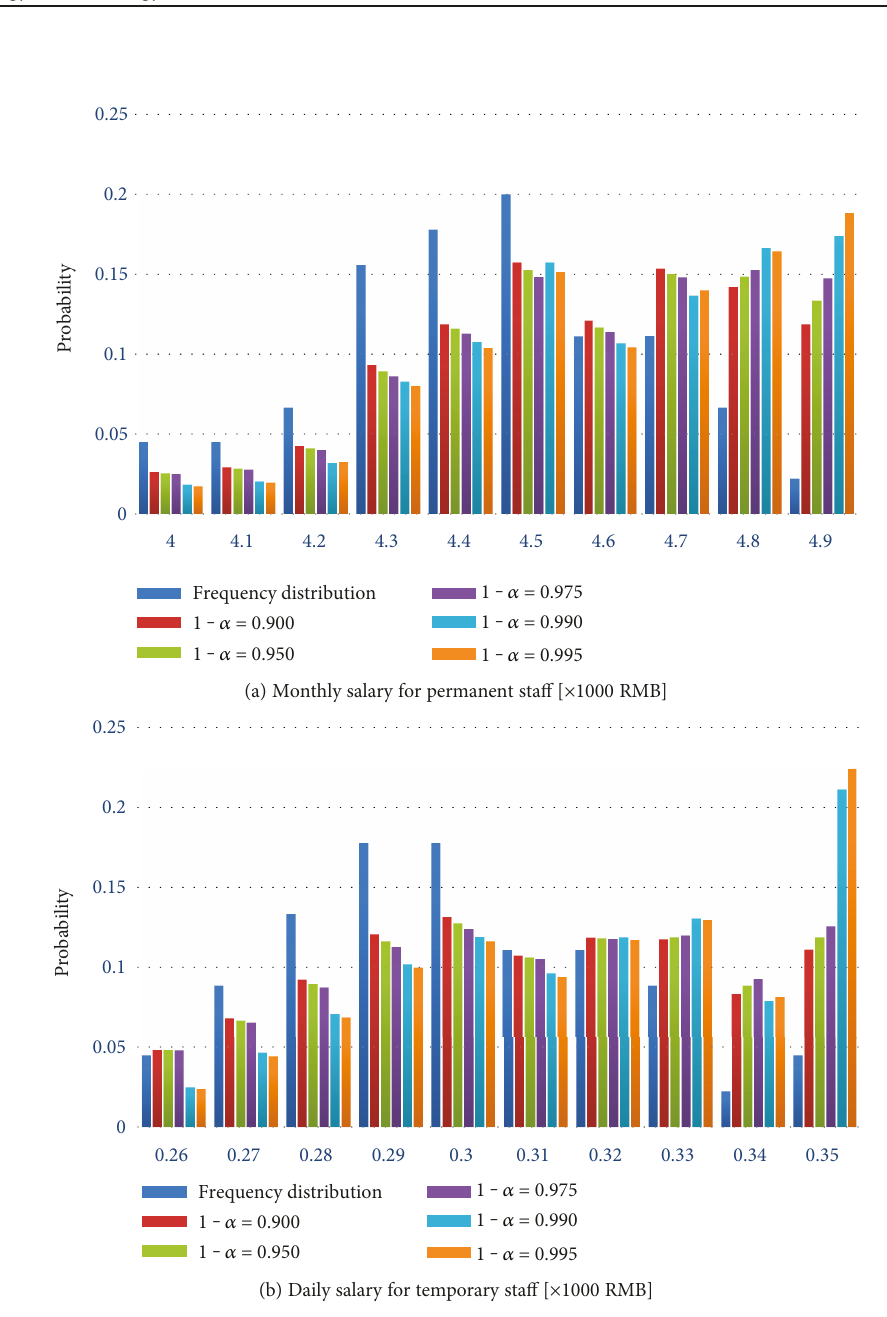
Figure 11: Distributions under di ff erent con fi dence